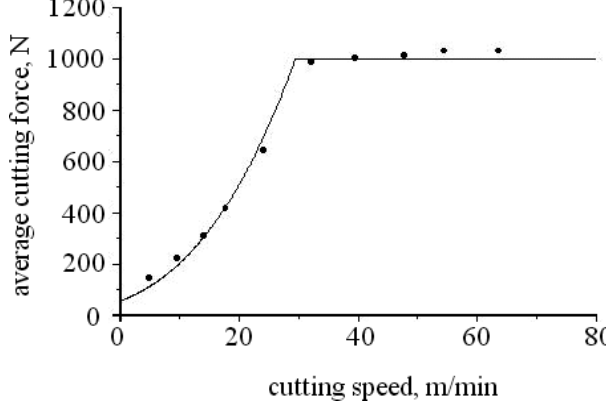
Fig. 5. Average force created on the cutter as a function of material feeding rate for ultrasonic assisted cutting of Inconel 718 alloy: f = 20 kHz, λ = 25 µ m. Comparison of theoretical predictions (solid line) with results of FEM